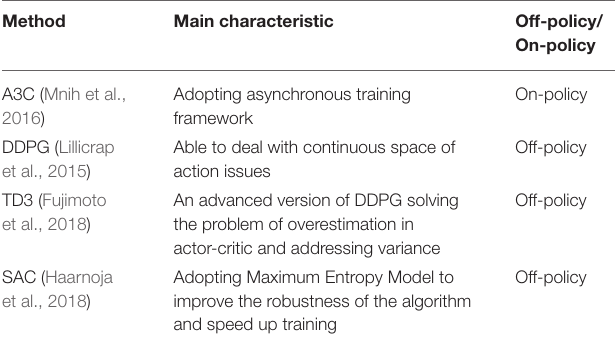
TABLE 4 | Summary of typical algorithms under the actor-critic